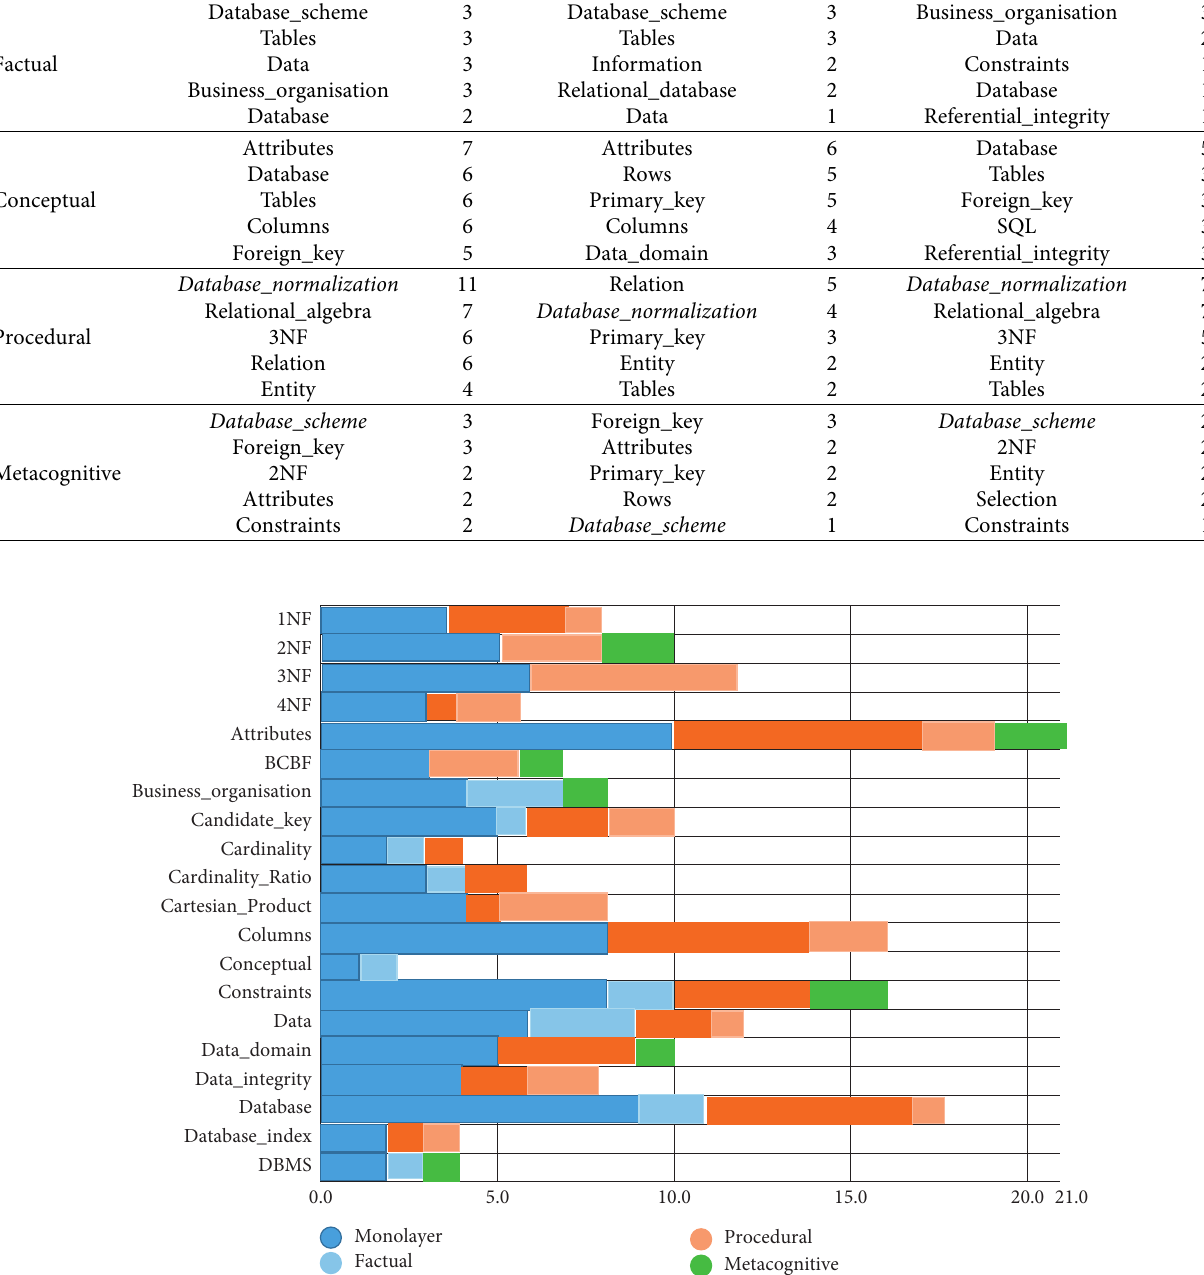
dc in dc out i ), in-degree i , and out-degree i values in a monolayer network.